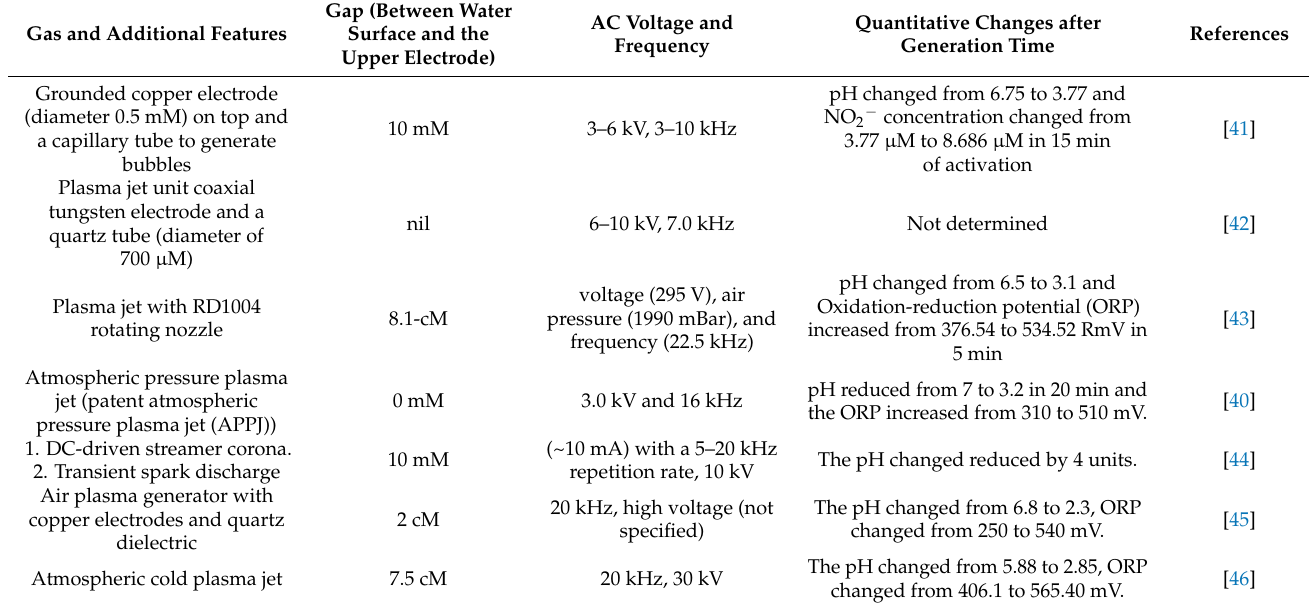
Table 1. The effect of different generation conditions and the characteristics of